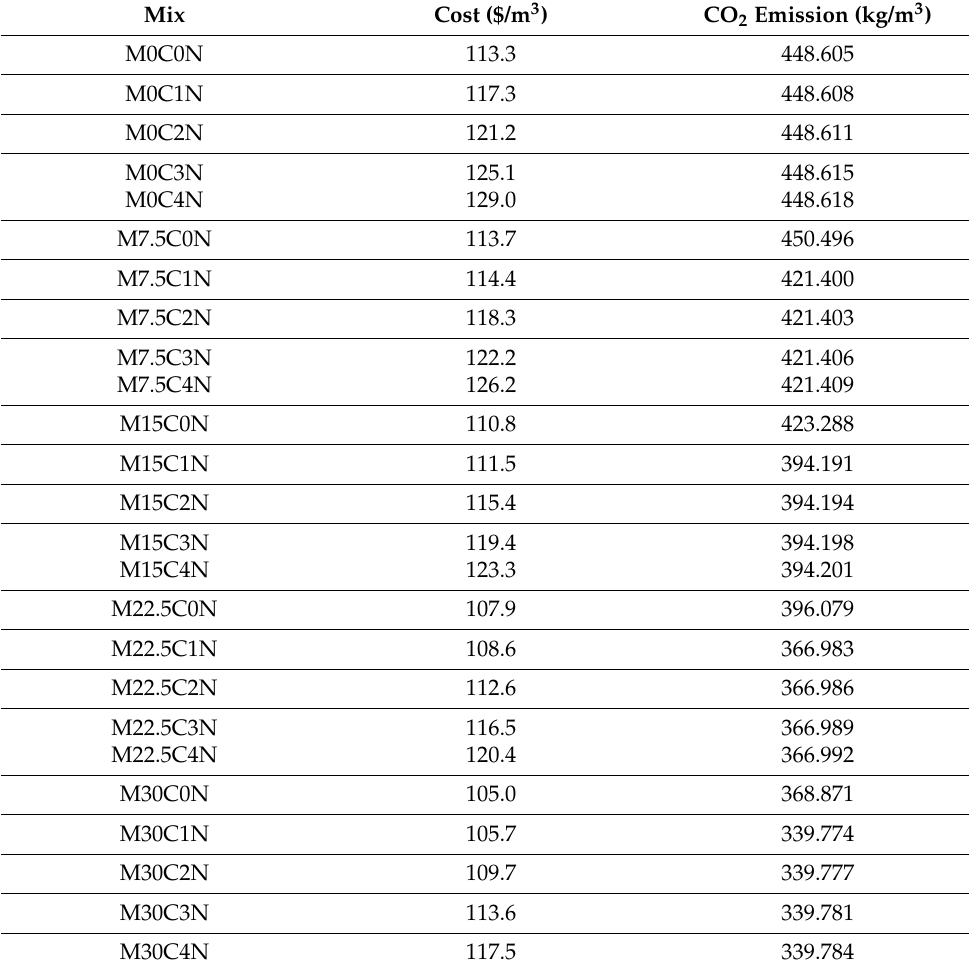
Table 5. Cost and CO 2 Emissions for CCR NS Concrete